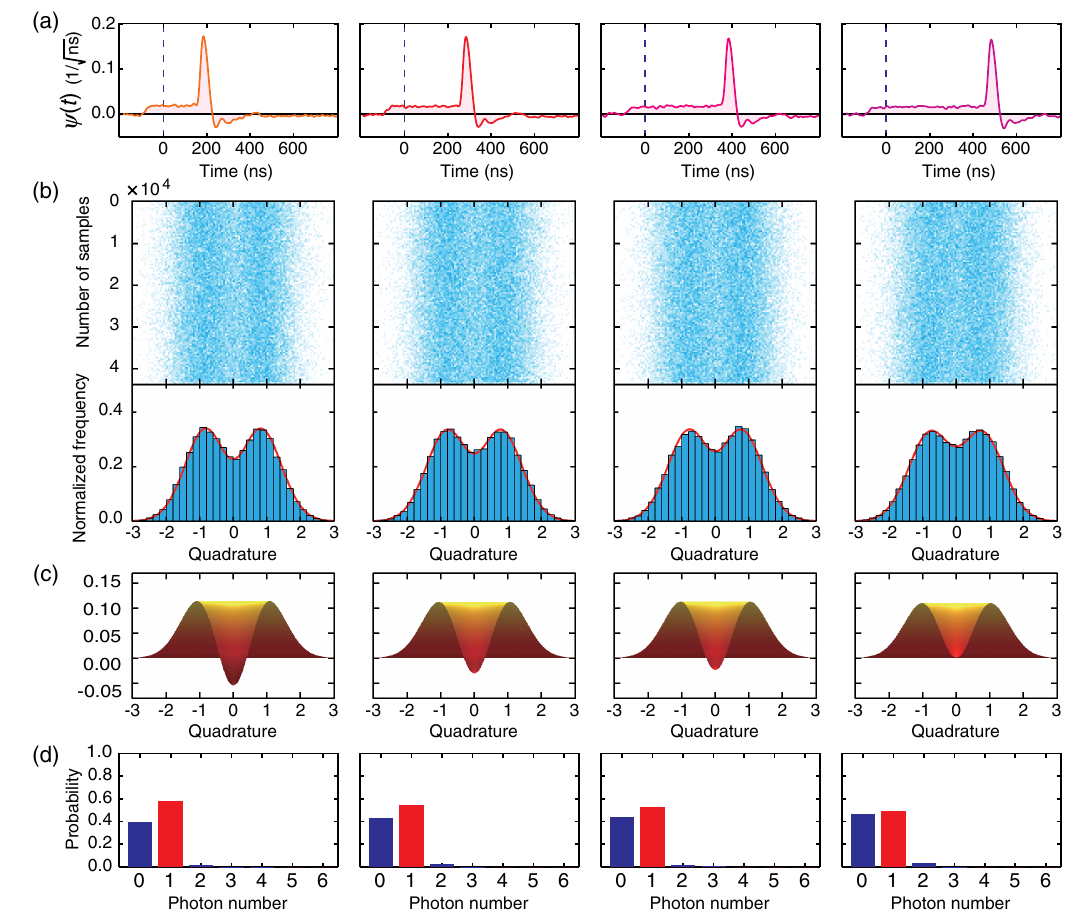
FIG. 2. Experimental results for various storage times. (a) Estimated wave-packet envelopes of the released photons. The idler- photon detection event corresponds to 0 ns. (b) Samples of quadrature amplitudes (upper boxes), their normalized histograms (blue in lower boxes), and their fitting curves (red in lower boxes). The sample number is 4 : 3 (cid:2) 10 4 . (c) Sectional side view of the Wigner functions cutting through the phase-space origin. (d) Photon-number distributions. (c) and (d) correspond to the fitting curves in (b). No correction of losses is performed in the data processing. The storage times are 0, 100, 200, and 300 ns, in addition to an intrinsic delay of 150 ns, corresponding to the columns from left to right. The values of the Wigner functions at the origin are (cid:1) 0 : 054 , (cid:1) 0 : 030 , (cid:1) 0 : 024 , and 0.001 from left to right,